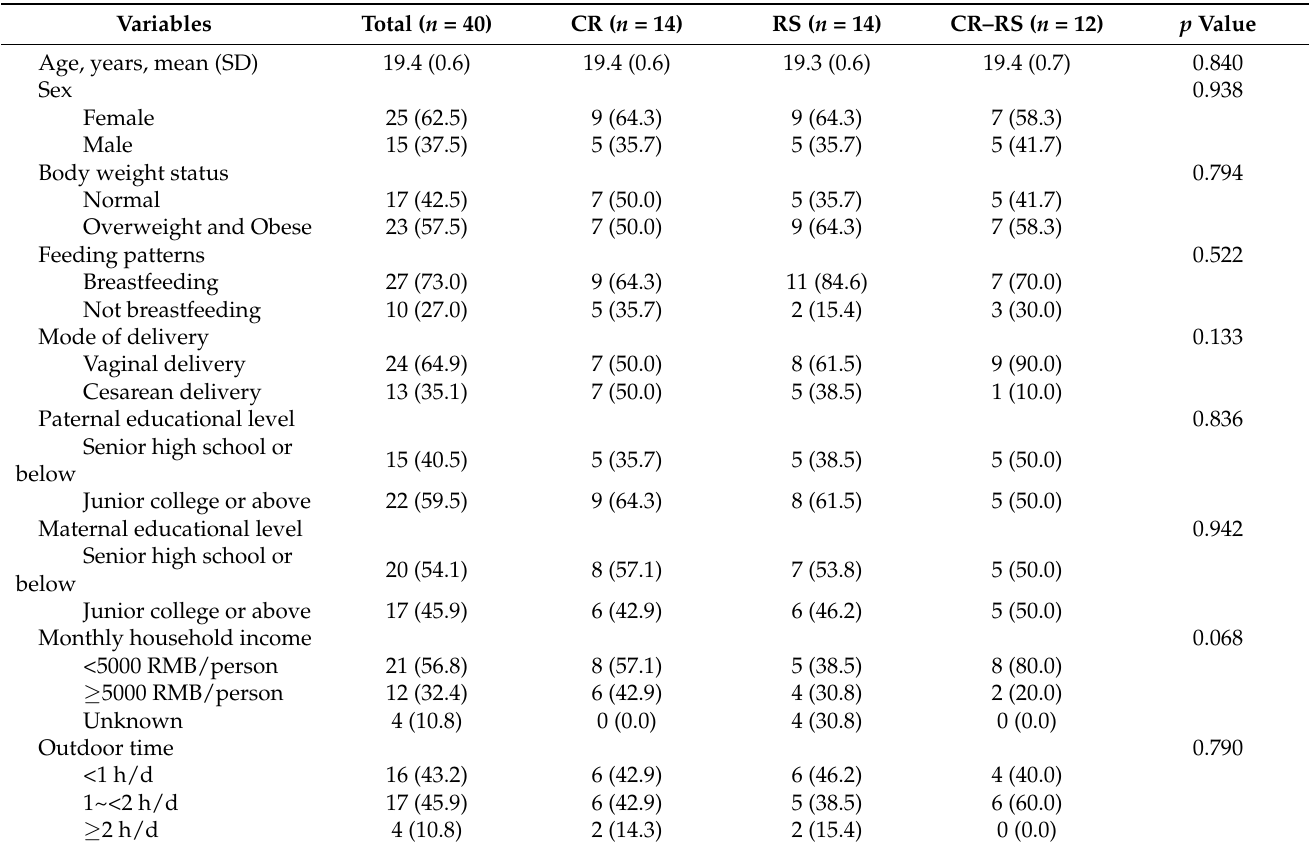
Table 1. The baseline characteristics of